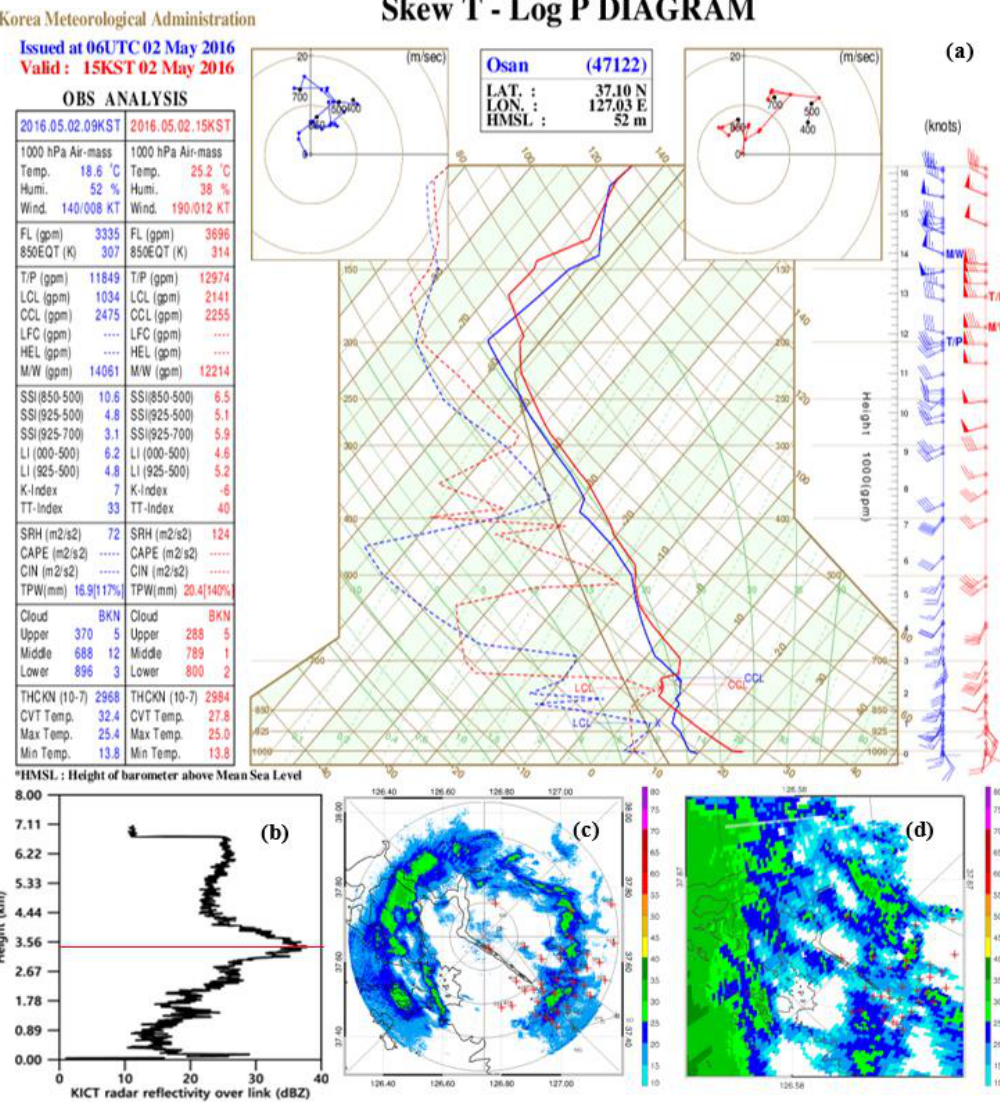
Figure 11. ( a ) Upper-air sounding data at Osan station. The blue and red solid lines represent temperature and dew-point temperature, respectively, and the areas shaded with red and blue colors represent the convective available potential energy and convective inhibition, respectively, ( b ) profile of X-band radar reflectivity at azimuth 134 ◦ at 17:31 LST on 2 May 2016. Spatial distributions of the ( c ) X-band and ( d ) the S-band radar reflectivity.